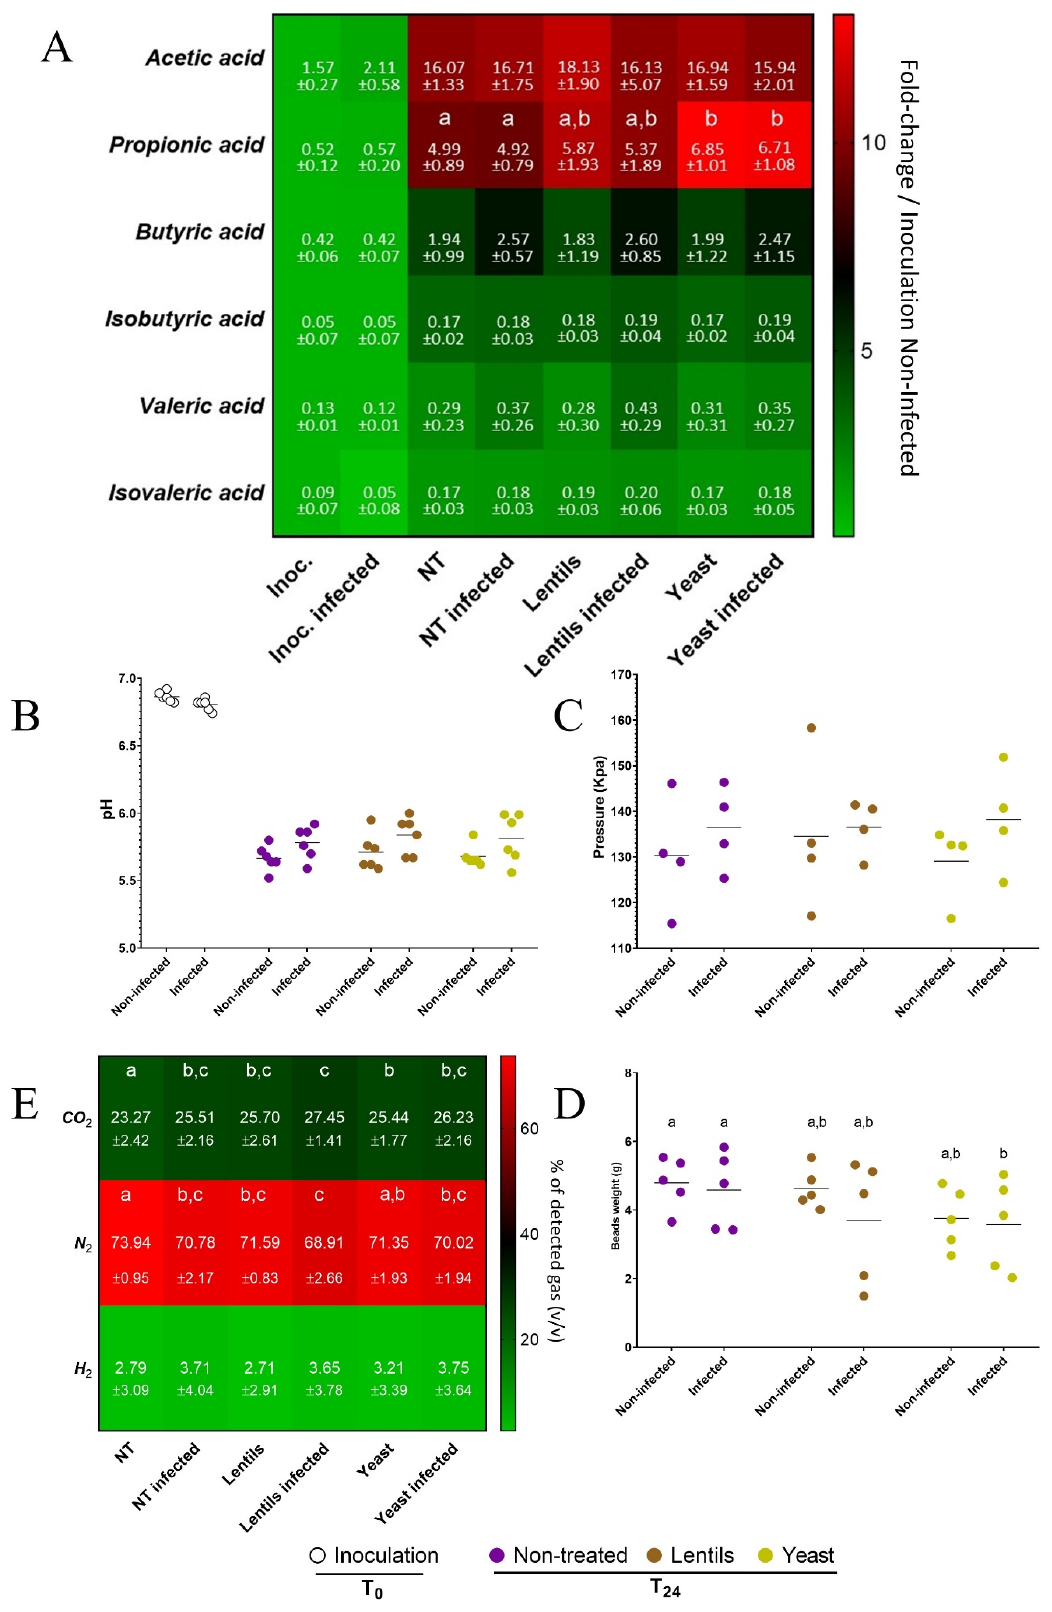
Figure 11. Modulation of gut microbial activity by ETEC infection and